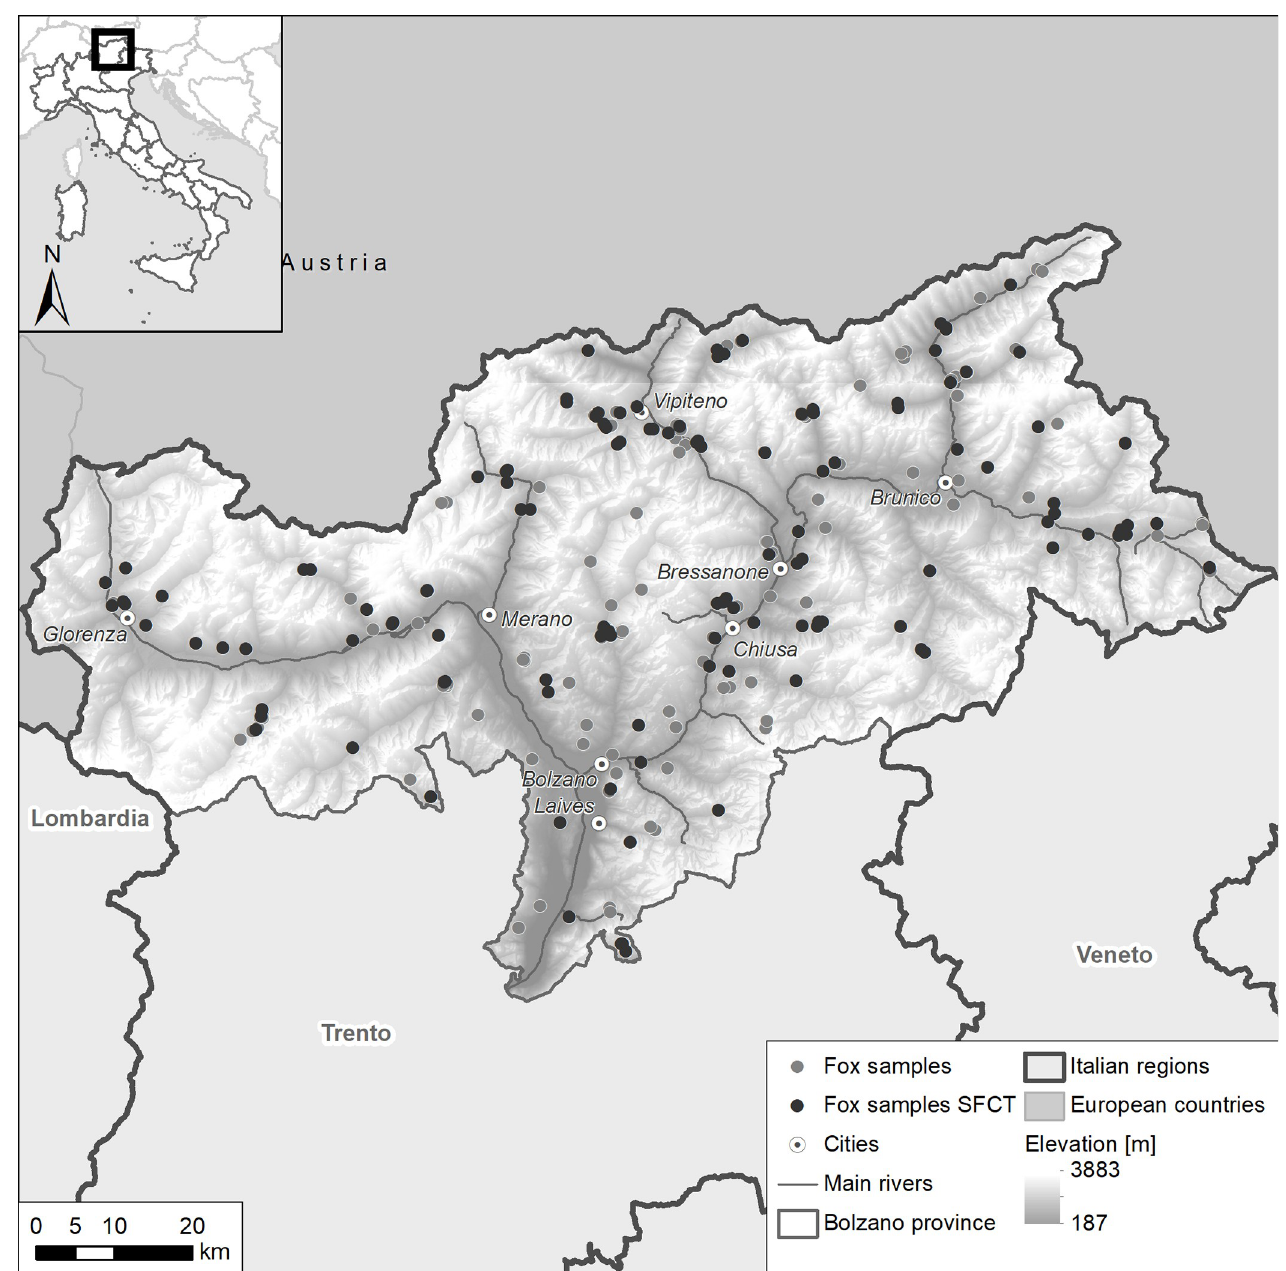
Fig 1. Distribution of individual fox faecal samples from Alto Adige in 2019–2020 (n = 235), indicating the subset examined for adult Echinococcus multilocularis worms by SFCT (n = 123). The DEM used as baselayer is provided by TINITALY. The data are available under license CC BY